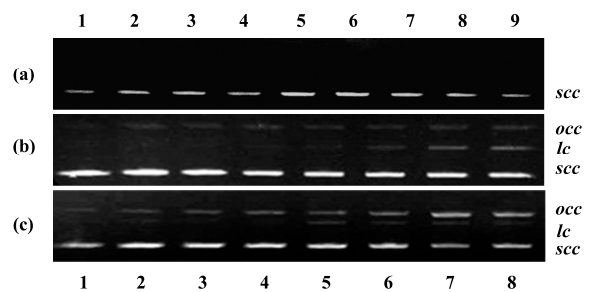
Figure 8. Agarose gel electrophoresis of pBR322 DNA (0.05 µg) with different concentrations of Ru-Lbpy 1 and Ru-Lbpy 2 complexes. ( a ) control without photoirradiation (Lane 1: DNA only; Lane 2-5: DNA + Ru-Lbpy 1 , 1, 10, 100, 200 µM; Lane 6–9: DNA + Ru-Lbpy 2 , 1, 10, 100, 200 µM) ( b ) DNA + Ru-Lbpy 1 with photoirradiation (Lane 1: DNA only; Lane 2–8: 1, 5, 10, 25, 50, 100, 200 µM) ( c ) DNA + Ru-Lbpy 2 with photoirradiation (Lane 1: DNA only; Lane 2–8: 1, 5, 10, 25, 50, 100, 200 µM).